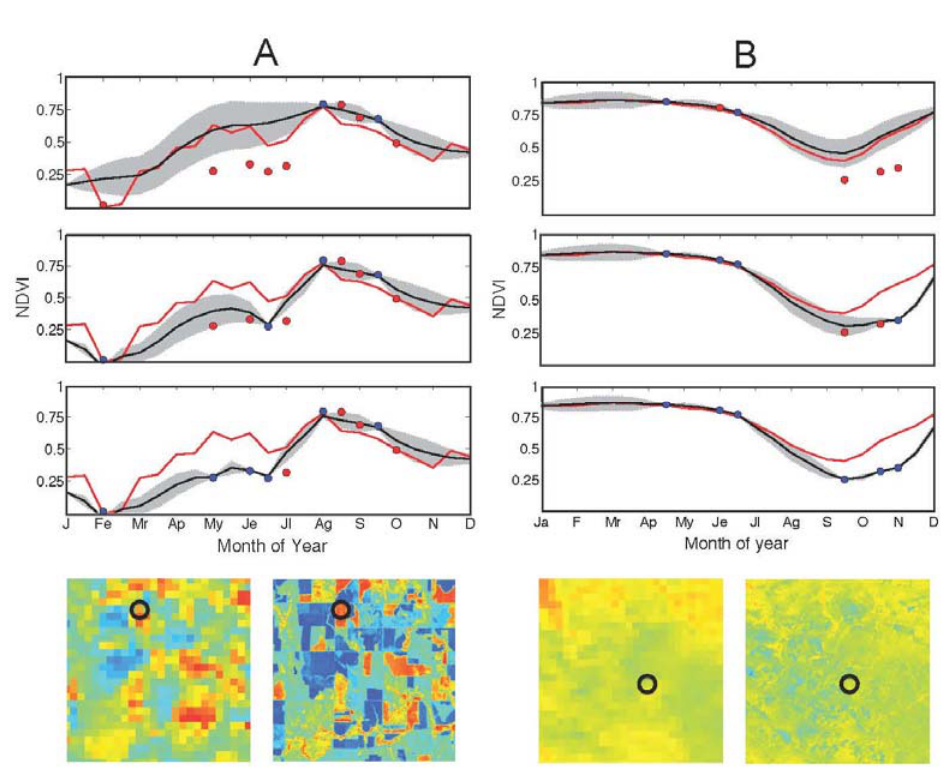
Figure 7. NDVI pixel-level values for combined mode Kalman filter implementation time series for ( A ) Kansas, ( B ) Mozambique, ( C ) Manitoba and ( D ) Arizona for a variable number of Landsat images as model observations. The black line shows the NDVI time series retrieved from the Kalman filter implementation. The grey area indicates model uncertainties (±standard deviation from the model estimate). The red line shos the average seasonal NDVI pattern extracted from the MODIS NDVI 16-day composites (MOD13Q1). The blue dots indicate the time steps for which Landsat images where used as model observations. The red dots indicate the time steps for which Landsat images where not used as model observations. The images display snapshots of MODIS and synthetic Landsat images. The black circle in the NDVI snapshots indicates the location of the pixel shown in the time